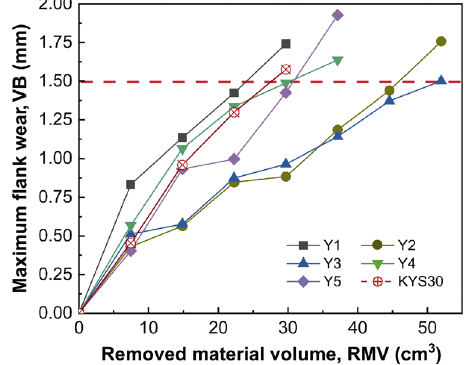
Fig. 13 Corresponding maximum flank wear measured from Fig.